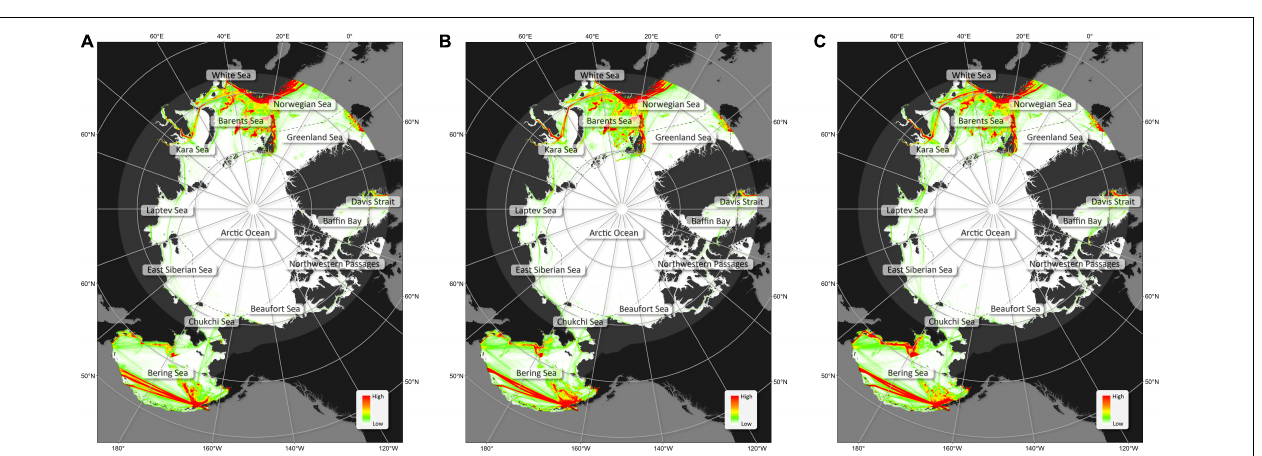
FIGURE 2 | Relative track densities of all vessel types in (A) 2015, (B) 2016, and (C) 2017. Areas with no color indicate no vessel traffic or low traffic volumes relative to other locations.